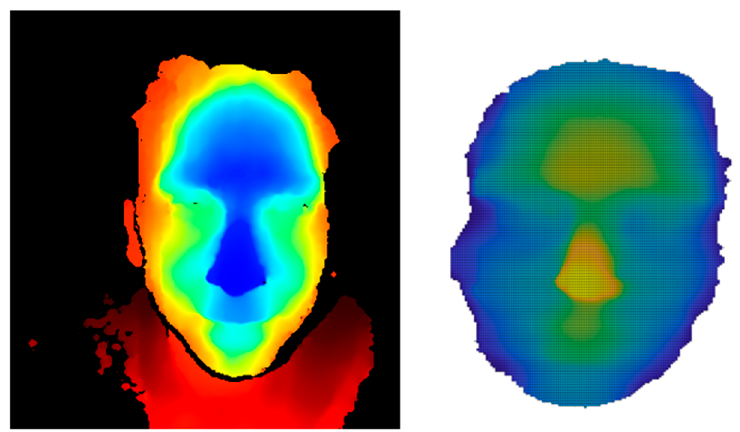
Figure 5. Depth map as output of the structured-light sensor ( left ) and shell ( right ).